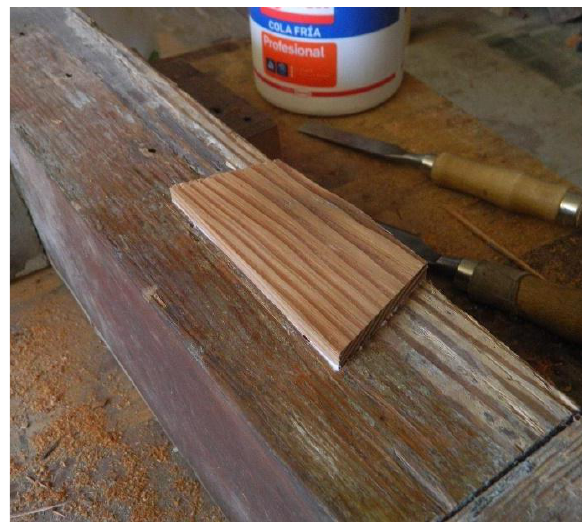
Figure 8. Integration in American Oregon pine.